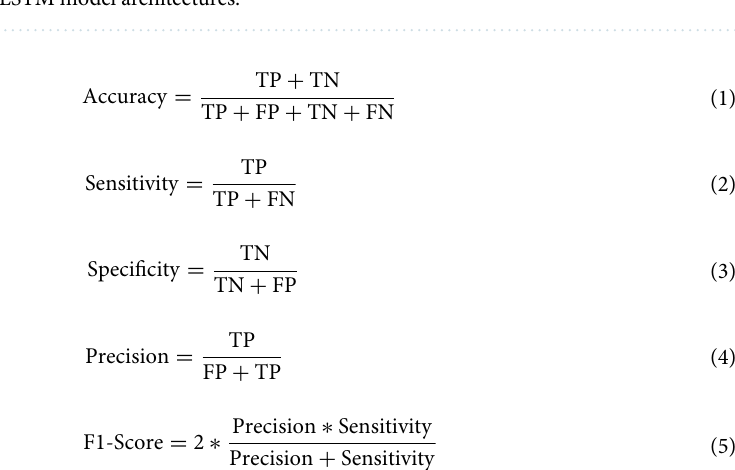
Figure 7. ( A ) CNN and ( B ) LSTM model